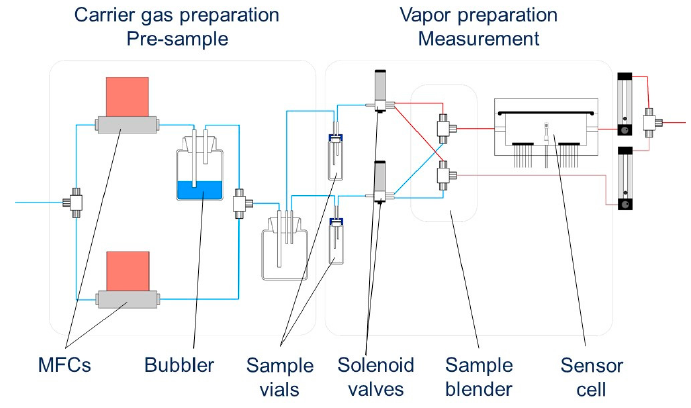
Figure 1. Schematic representation of the measurement system used in the study.